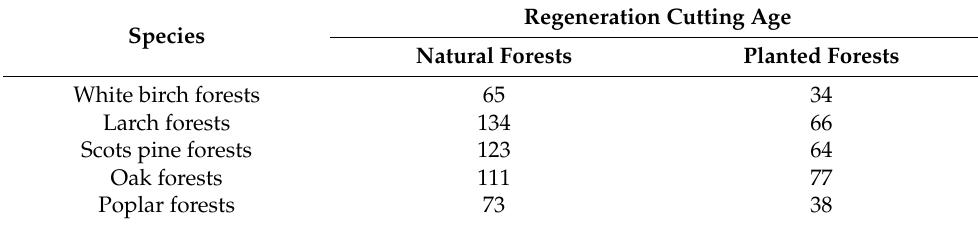
Figure 5. Comparison of carbon sequestration for comprehensive decision-making and carbon sequestration only. Table 3. Table of new regeneration cutting ages.